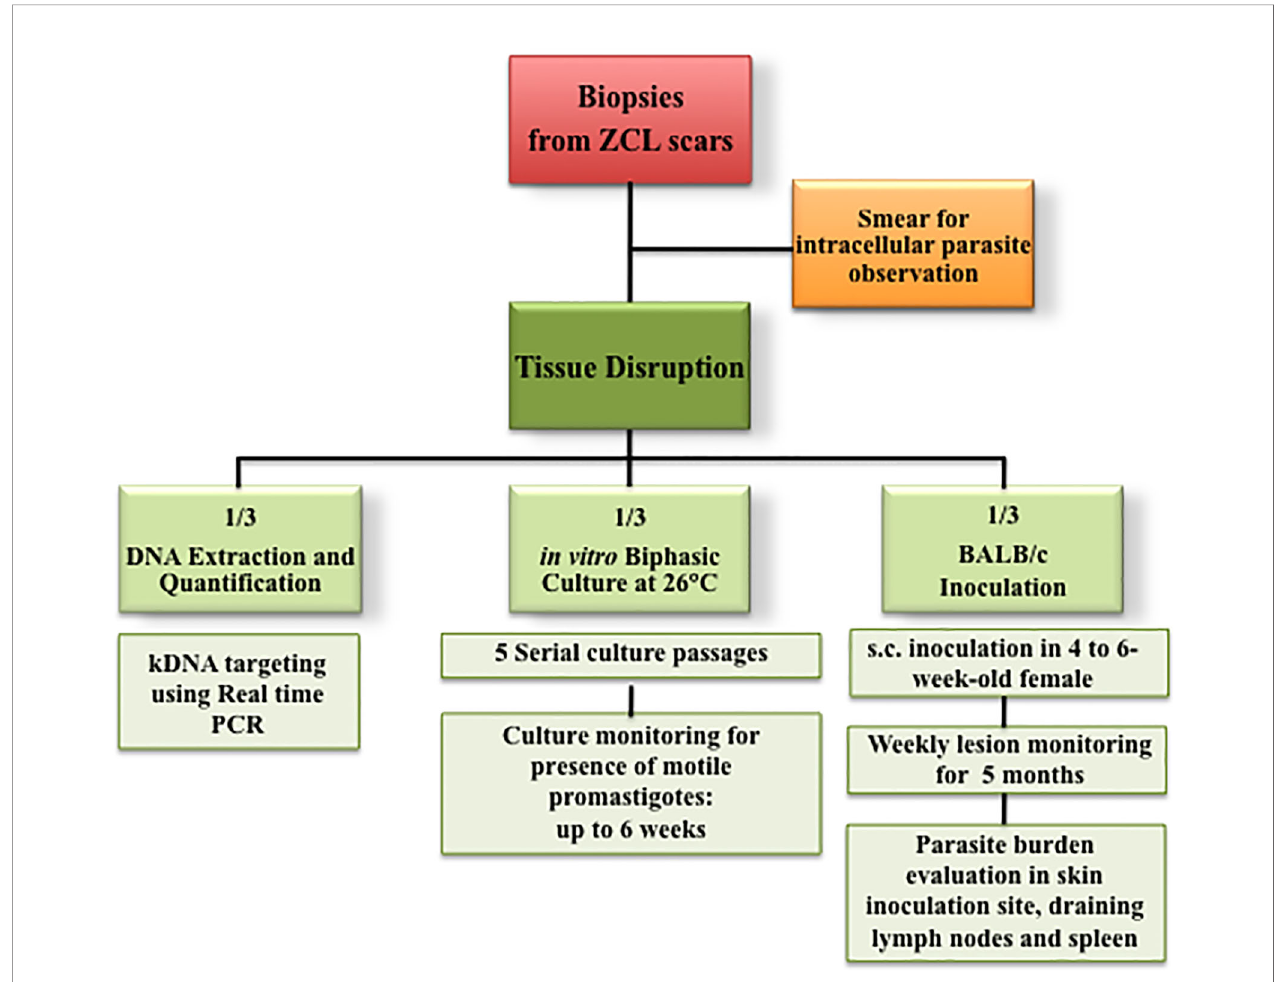
FIGURE 1 | Work fl ow chart of the experimental design for parasite detection in zoonotic Human cutaneous leishmaniasis-healed